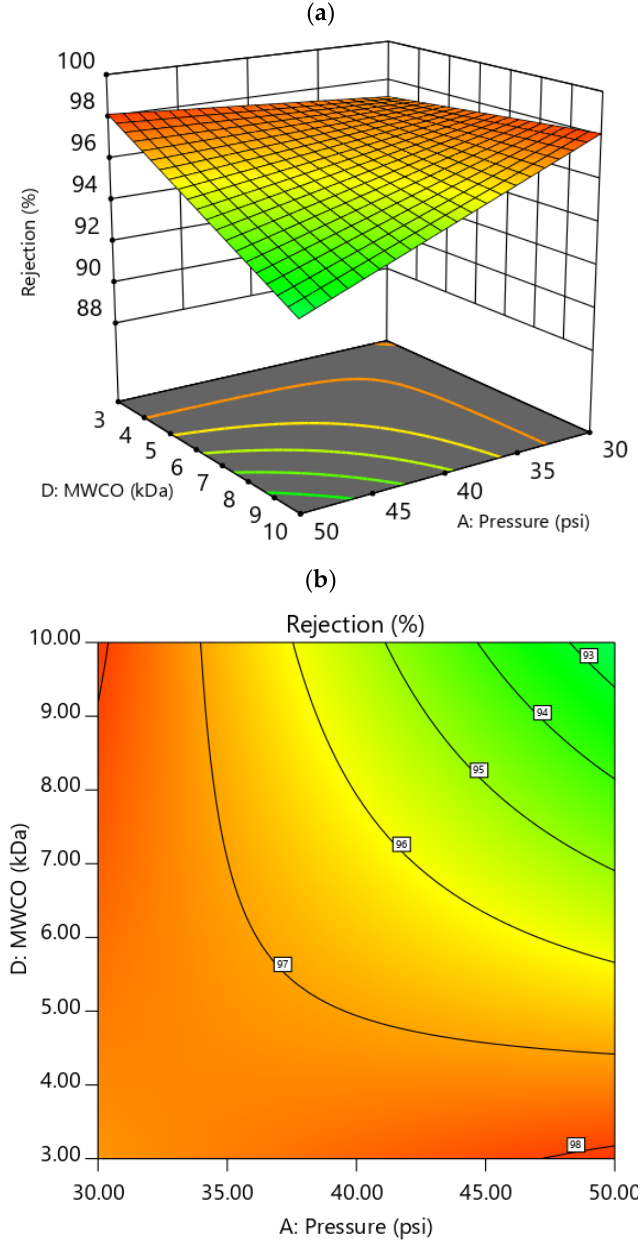
Figure 2. Response surface ( a ) and contour ( b ) showing the effect of pressure and MWCO on rejection rate. C Ni = 1.25mM, C SDS = 16.6mM.